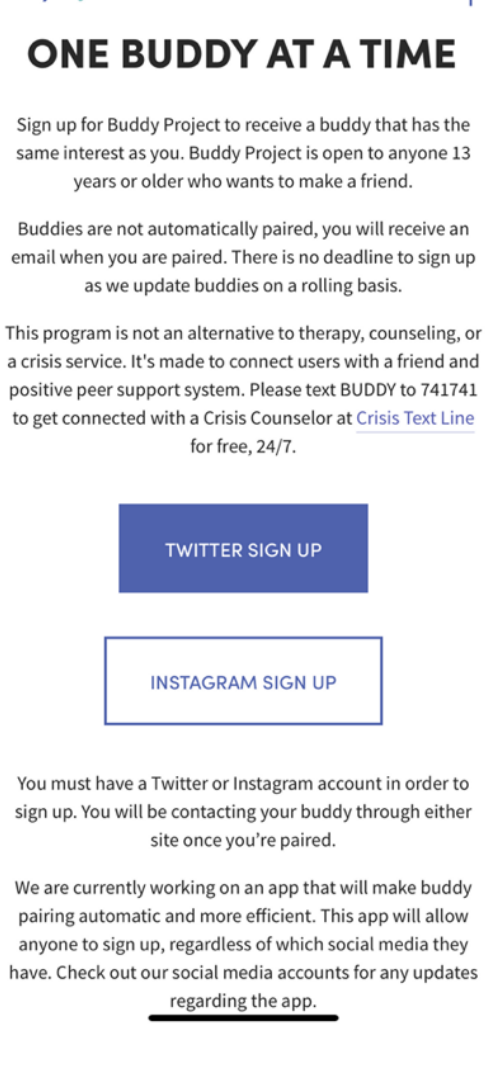
Figure 2. The sign-up page on the Buddy Project